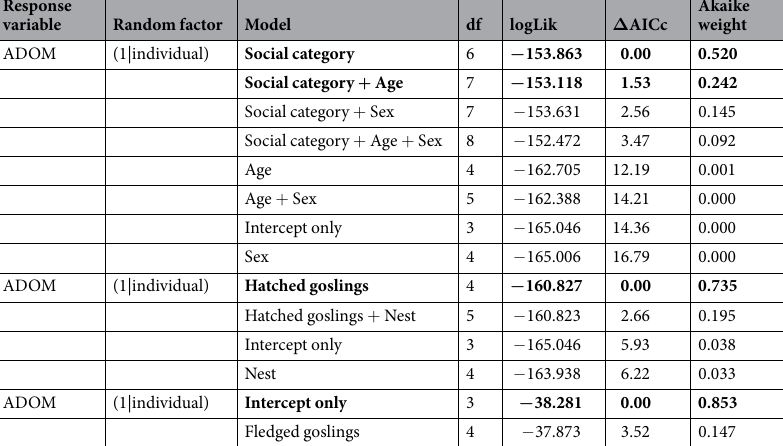
Table 1. Top-ranked models. Given are the predictors modulating the response variable ‘apparent digestibility of organic matter’ (ADOM). Model selection table. Parameters explaining the response variable apparent digestibility of total organic matter are given. Bold indicates top-ranked models. df – degrees of freedom, logLik – log- likelihood, Δ AICc – differences of the second-order Akaike information criterion between the best model and the other top-ranked models.